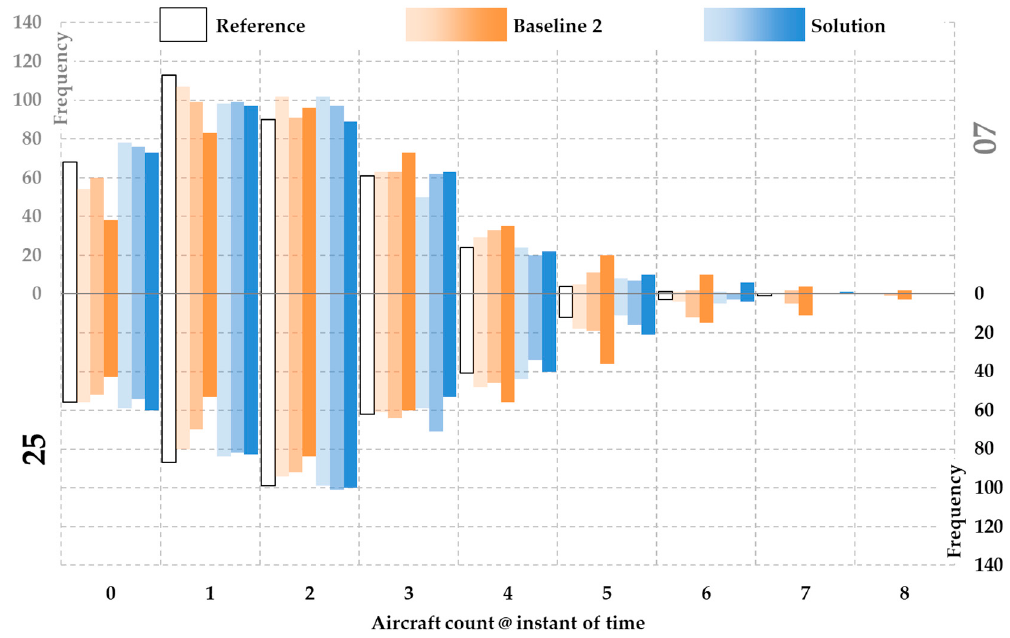
Figure 7. Aircraft on-ground frequency distribution (both runway directions).